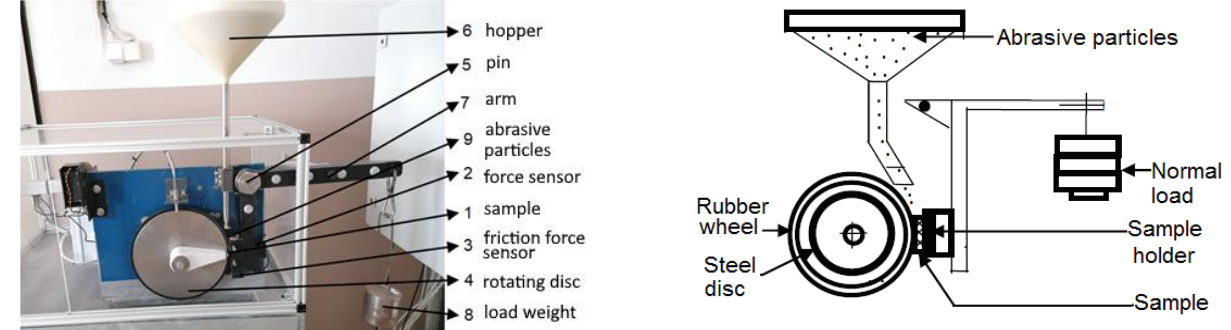
Figure 2. Real tribological laboratory equipment ( left ) and schematic representation ( right ). Table 2. ASTM G65-16 parameter settings during the testing process.